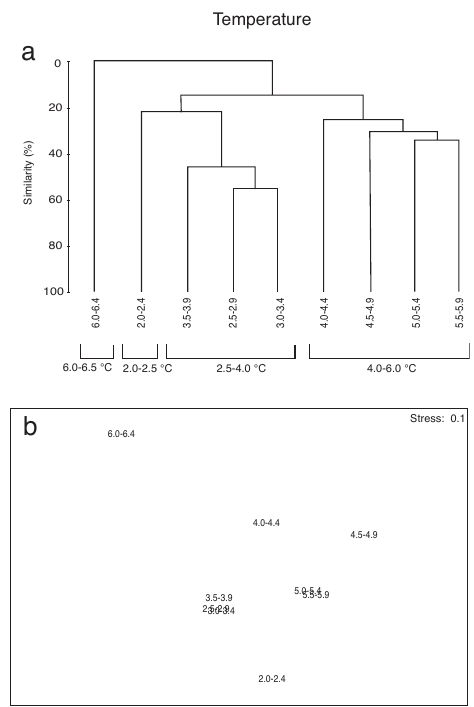
F IG . 4. – Temperature ranges (grouped to the nearest 0.5°C), according to polychaete densities. a) Dendrogram (Bray-Curtis sim-